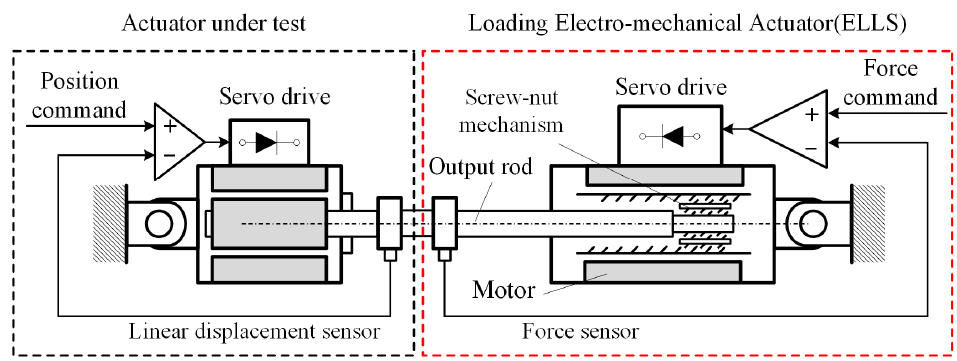
Figure 1. Architecture of the ELLS and tested actuator.